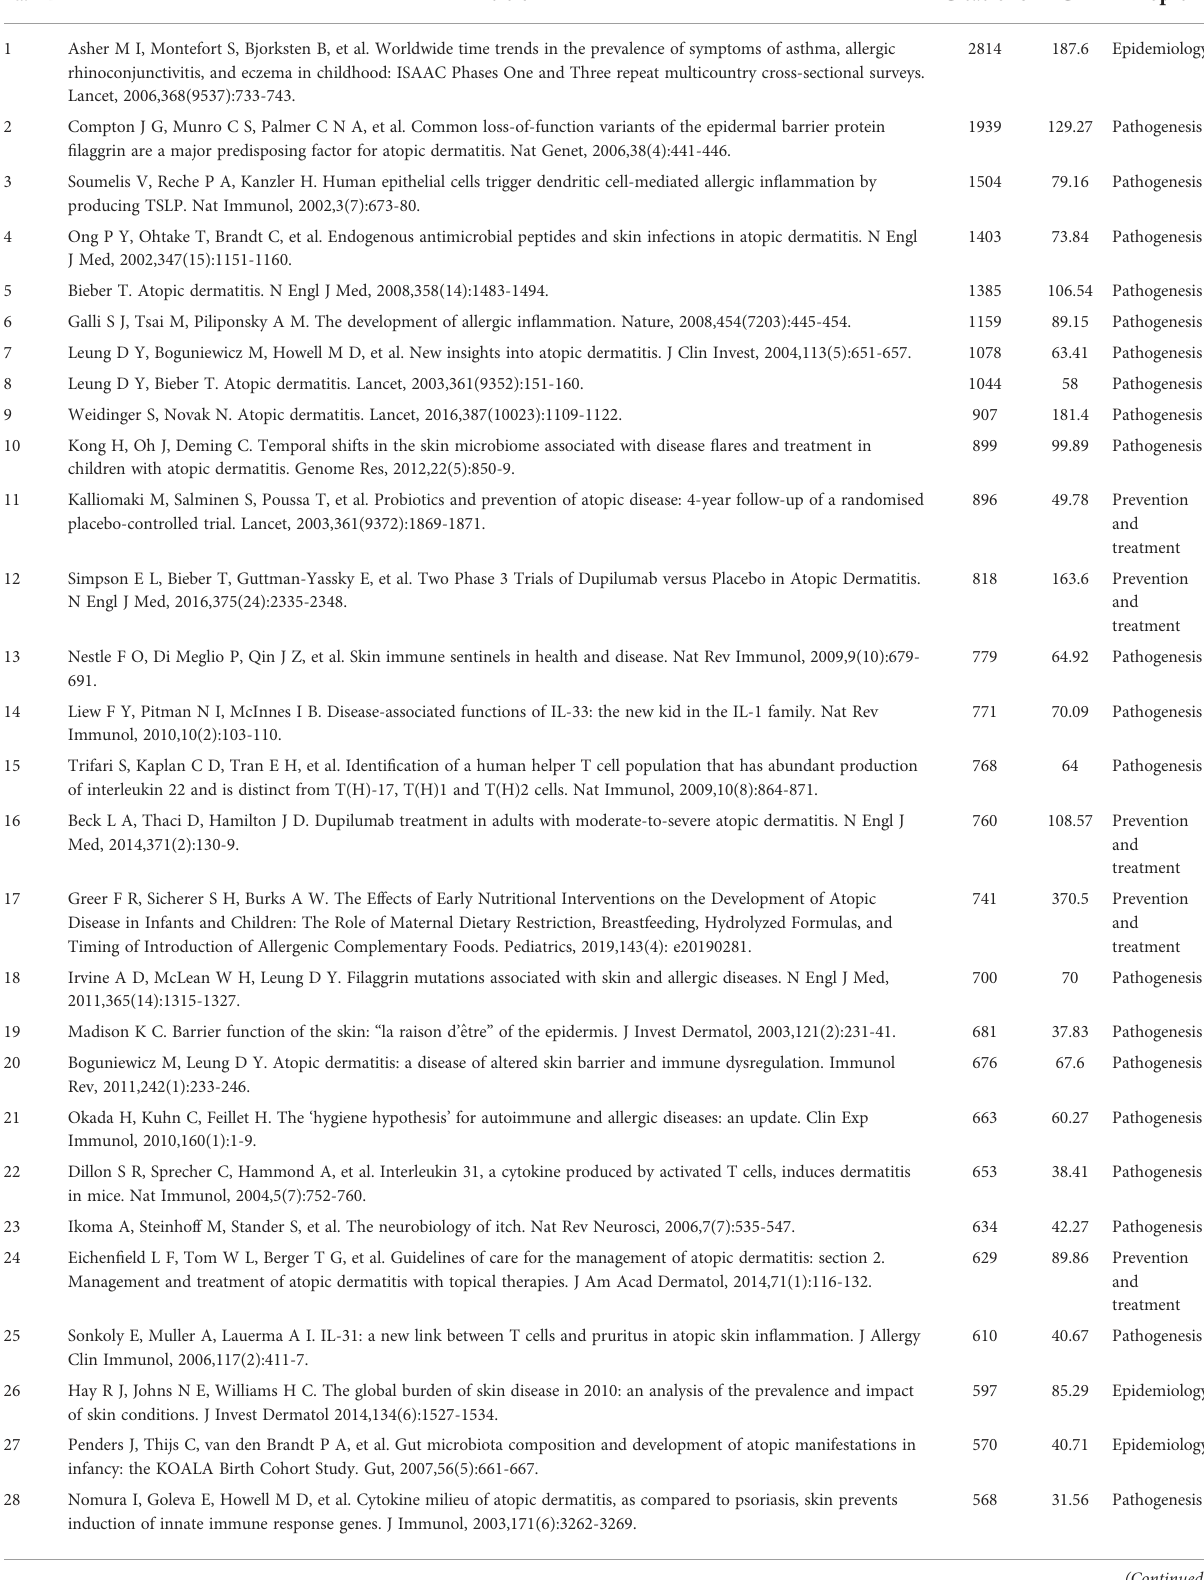
TABLE 1 The top 100 cited articles on atopic